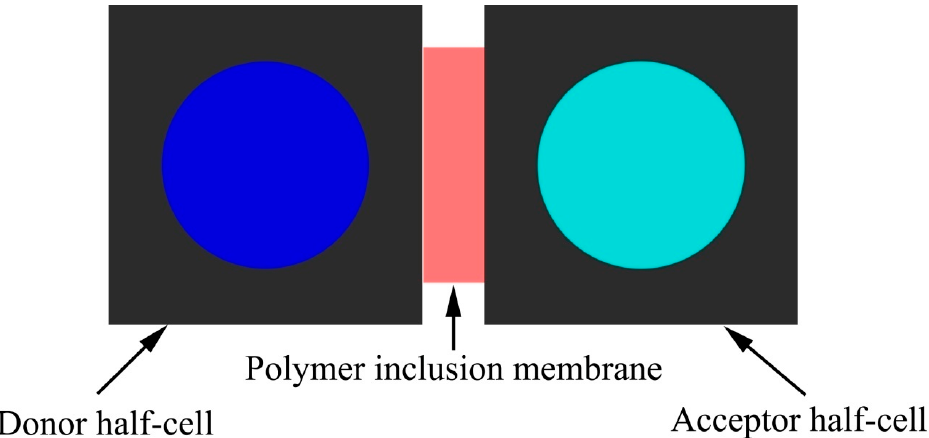
Figure 2. Experimental setup for the pharmaceuticals extraction with Polyvinyl chloride/dibutylphtalate/ poly( β -cyclodextrin) membrane extraction cell. In the donor half-cell there is initially 60 mL of aqueous solution of the drug (ibuprofen or progesterone) at 10 ppm. Sample for measurements were taken from acceptor half-cell.